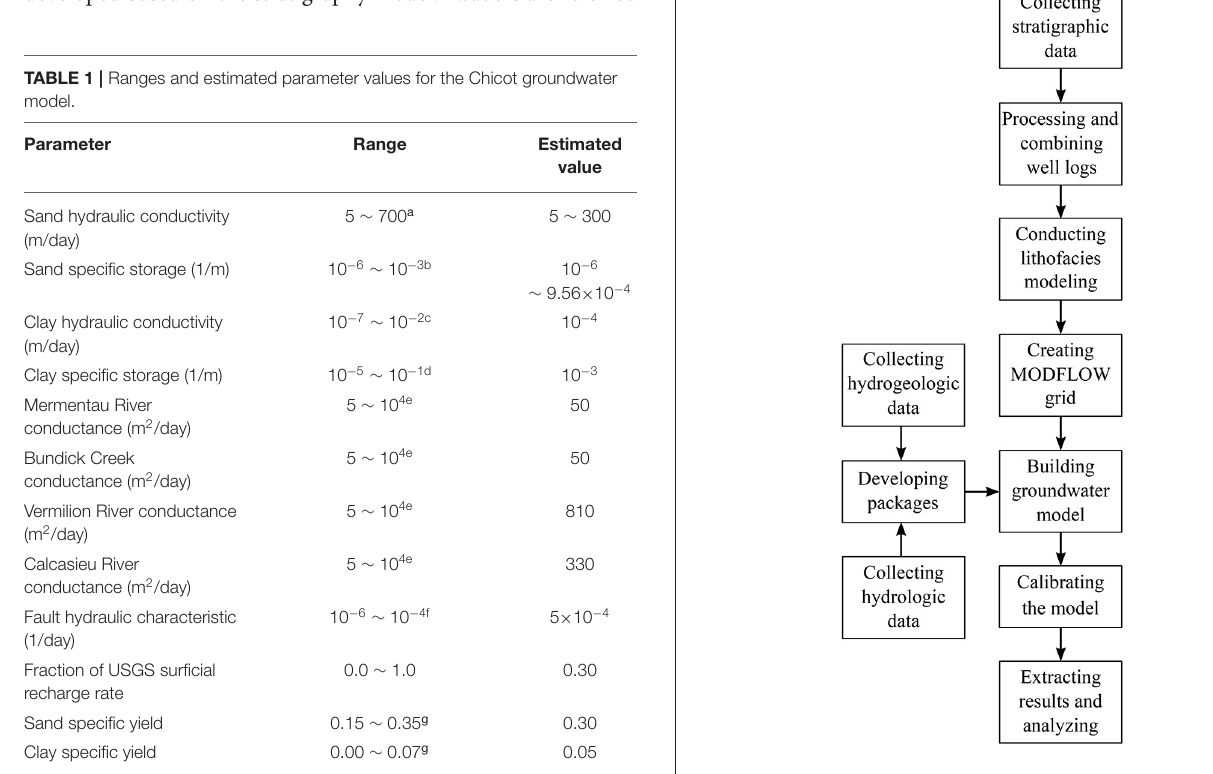
Frontiers in Water |